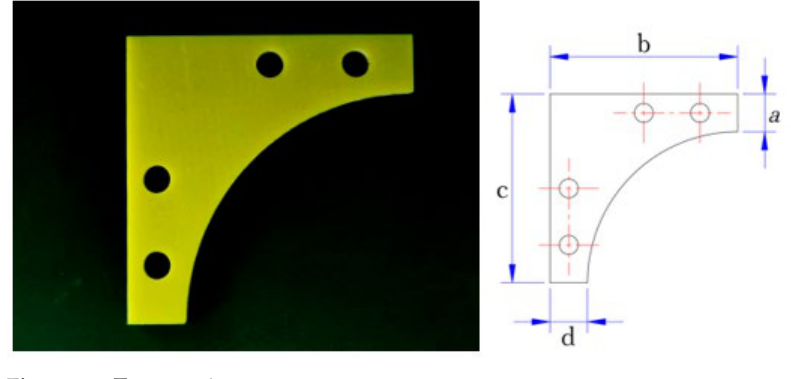
Figure 25. Test part 1.